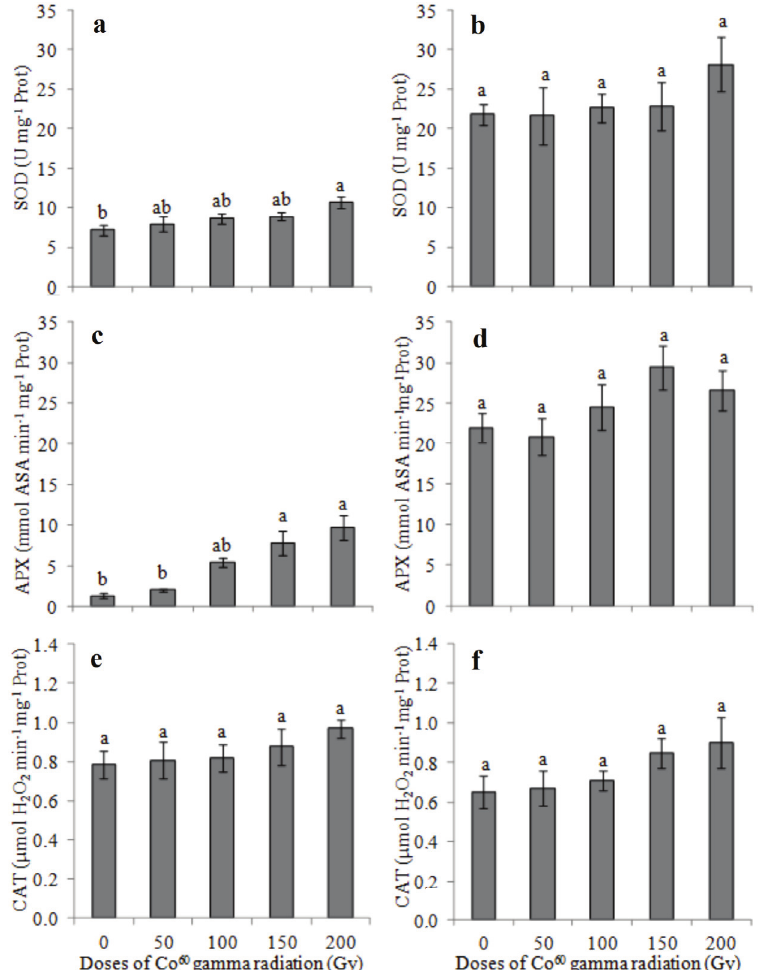
Figure 5 - Activities of the antioxidant enzymes SOD, APX and CAT in the leaves (fi rst column) and roots (second column) of castor bean seedlings exposed to diff erent doses of Co 60 gamma radiation. Means followed by diff erent letters diff er by Tukey’s test (P <0.05). Bars represent the standard error of the mean of four